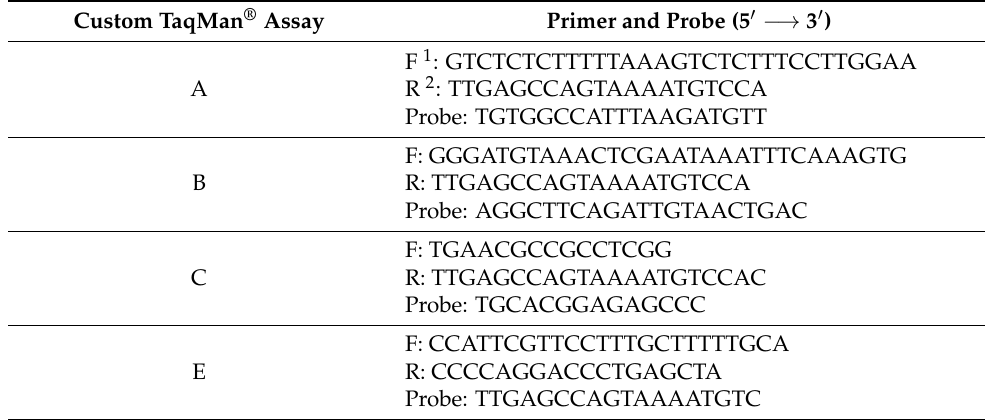
Figure 1. Schematic overview (not in scale) of TCF4 transcripts targeted by five TaqMan ® gene expression assays. Assay A shown in yellow targets 9 TCF4 transcripts; assay B shown in green targets 4 TCF4 transcripts; assay C shown in blue targets 11 TCF4 transcripts; assay E shown in purple targets 7 TCF4 transcripts; assay D shown in red targets 13 TCF4 transcripts, 12 of which overlap with those targeted by assays A, B, and C. mRNAs targeted by assay A-D span over the CTG18.1 tract and mRNAs targeted by assay E have TSS immediately at the 3 (cid:48) -end of the (CTG) n tract. Light grey boxes represent untranslated exons, dark grey boxes represent translated exons, and relative position of the CTG18.1 in the TCF4 gene is shown in black. NM—NCBI Reference Sequence (RefSeq). Table 1. Primer and probe sequences for custom TaqMan ®